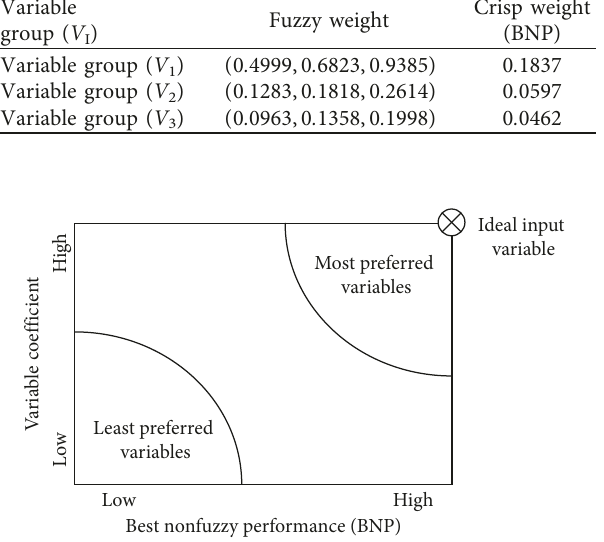
Figure 5: Preference for selecting input